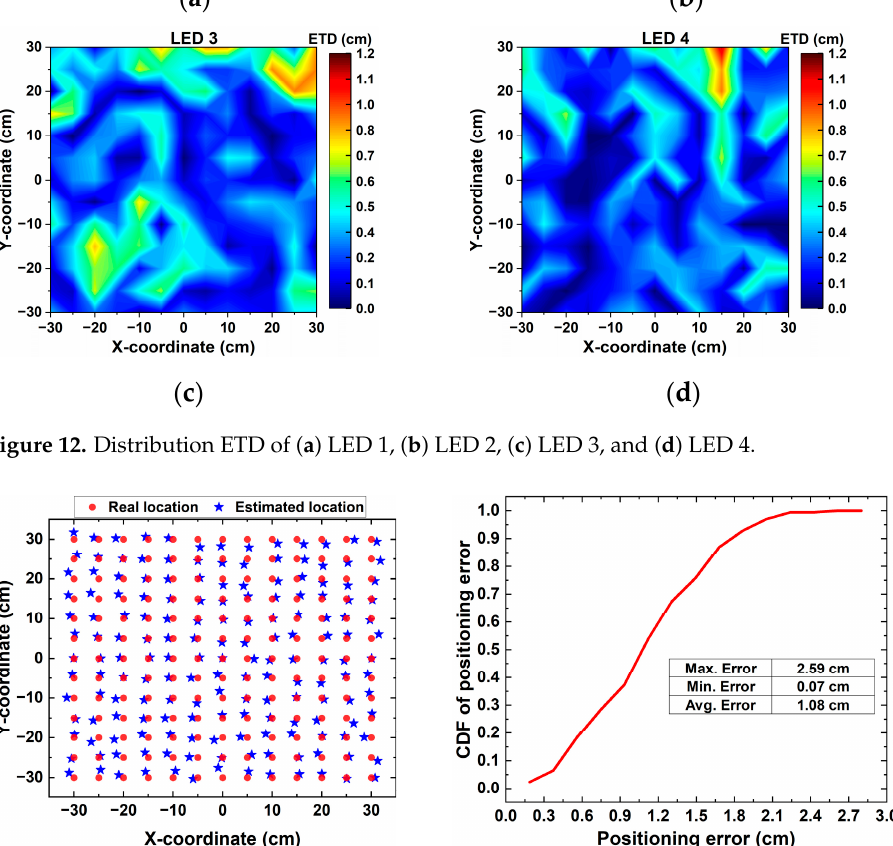
Figure 13. ( a )The real location and estimated location of each testing point and ( b ) the CDF of positioning error.